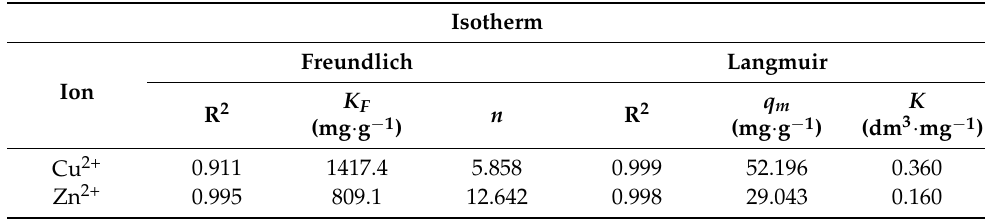
Figure 15. Freundlich isotherm fit for adsorption of copper(II) and zinc(II) ions onto studied adsorbent. Table 6. Freundlich and Langmuir isotherms parameters for adsorption of copper(II) and zinc(II) cations onto studied